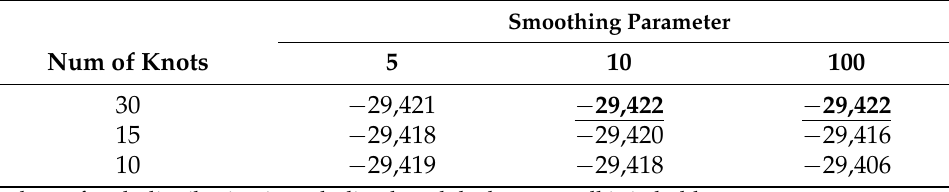
The best of each distribution is underlined, and the best overall is in bold. Table 25. DIC for Gamma distribution (27 July 2016, JAL, Tokyo, Japan). Smoothing Parameters